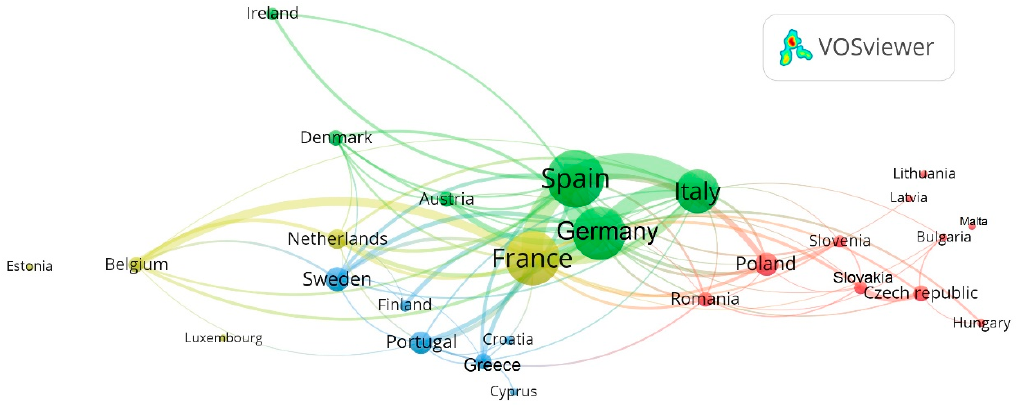
Figure 10. The country co-authorship interaction collaboration of the top 20 European Union countries.